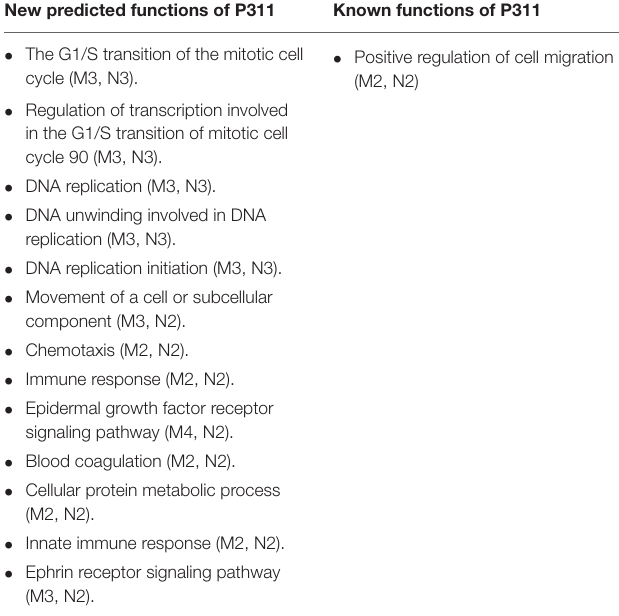
TABLE 2 | Predicted function of